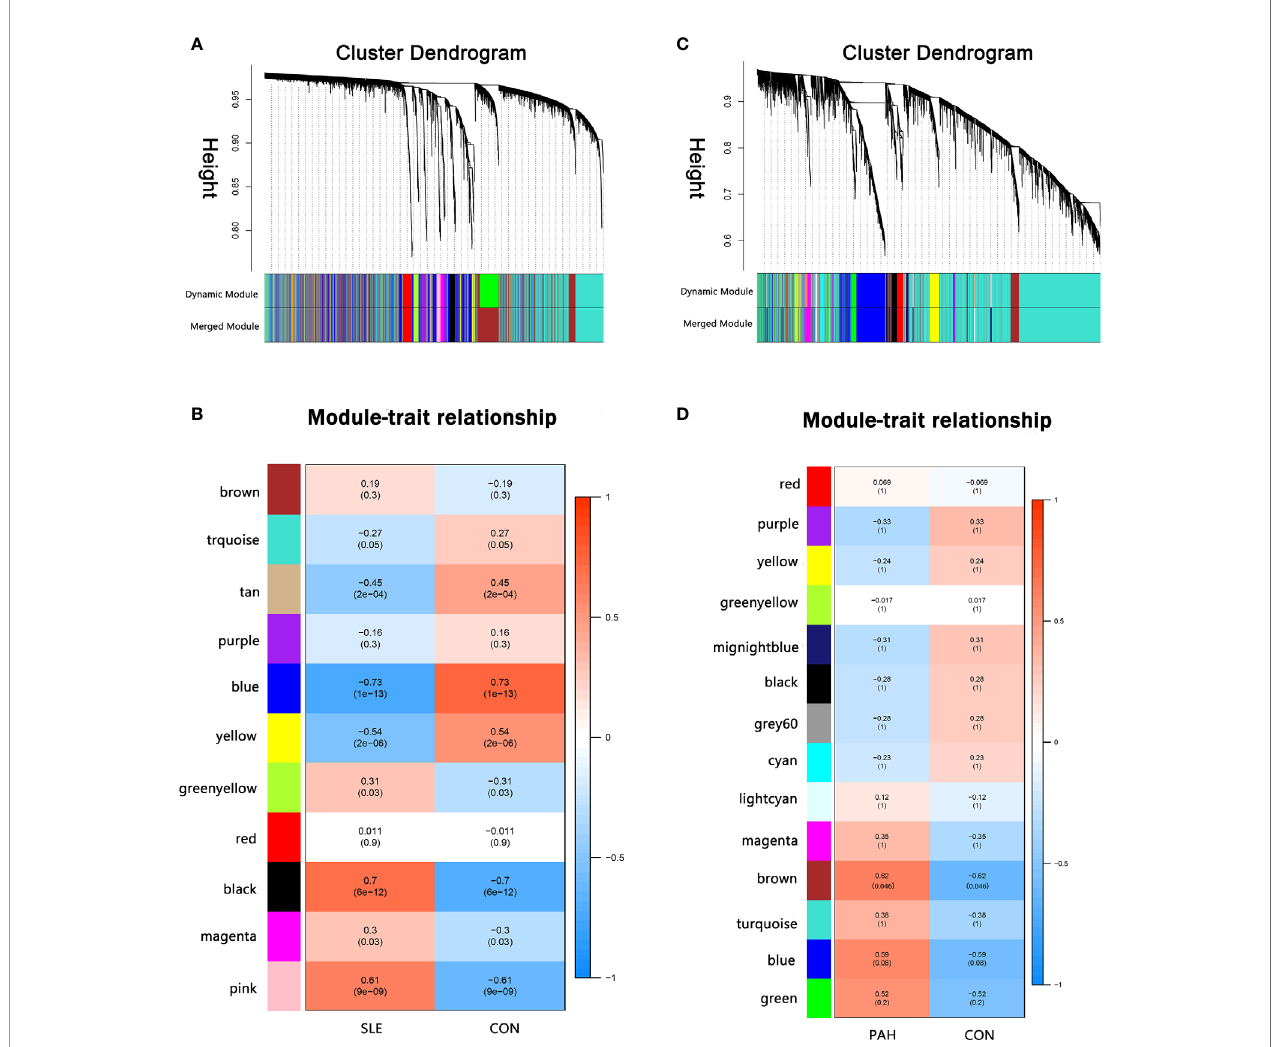
FIGURE 1 | Weighted gene co-expression network analysis (WGCNA). (A) The cluster dendrogram of co-expression genes in SLE. (B) Module – trait relationships in SLE. Each cell contains the corresponding correlation and p -value. (C) The cluster dendrogram of co-expression genes in PAH. (D) Module – trait relationships in PAH. Each cell contains the corresponding correlation and p -value. SLE, systemic lupus erythematosus; PAH, pulmonary arterial